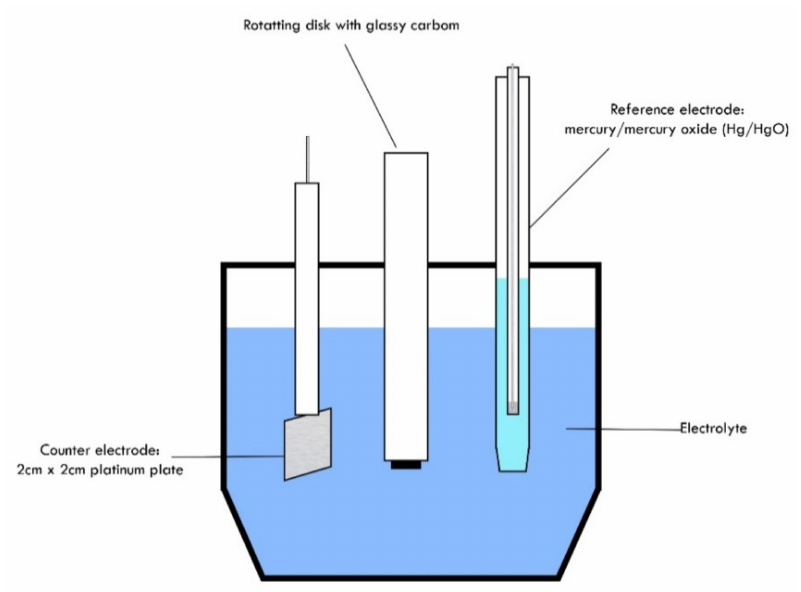
Figure 1. Typical three-electrode set-up for electrochemical characterization for